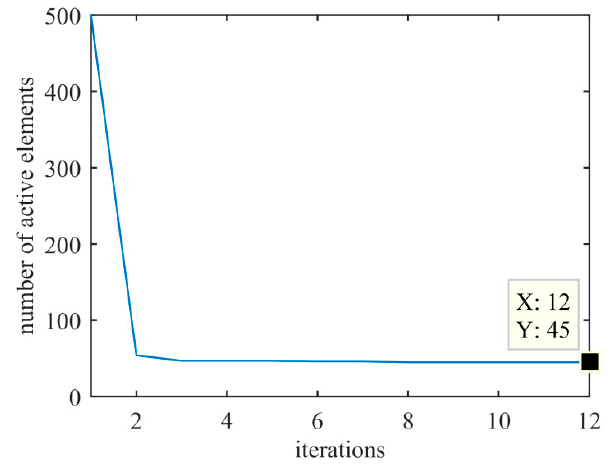
Sensors 2020 , 20 , x FOR PEER REVIEW Figure 9. Positions and weight values of active sensors. Figure 9. Positions and weight values of active sensors.